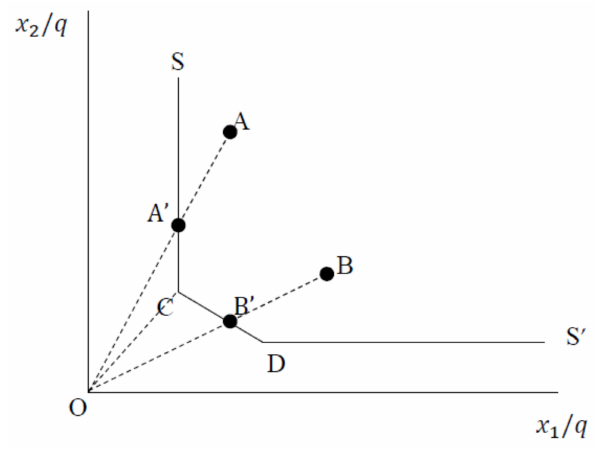
Figure 6. Input-oriented CRS-DEA